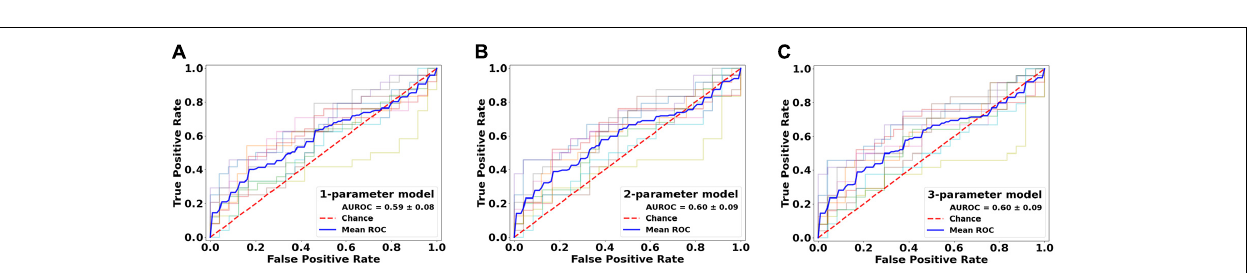
FIGURE 7 | Feature ranks and classification accuracies in lesion core-shell analysis. Top Panel: The mean (standard deviation) rankings of the nine diffusion features used in this analysis based on the linear recursive feature elimination (RFE) algorithm in SVM. Bottom Panel: Accuracy of the classification models (SVM-IC) achieved by adding features one at a time, starting from the highest to the lowest rankings. The stars indicate features that contribute to significant improvement in classification accuracy (**** p < 0.0001).